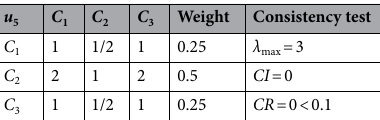
Table 7. Greenness of coatings judgment